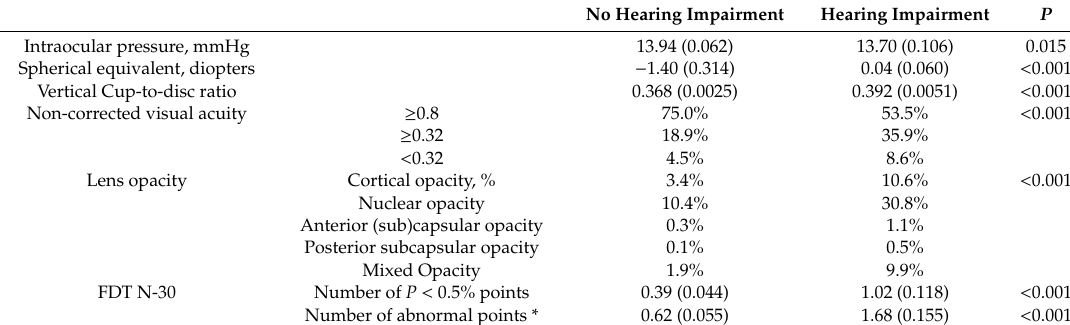
Table 2. Ocular parameters, right